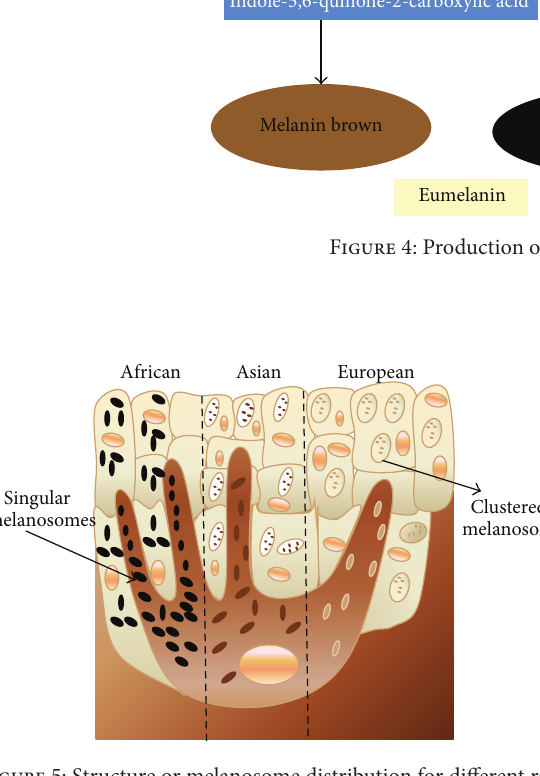
Figure 5: Structure or melanosome distribution for different racial